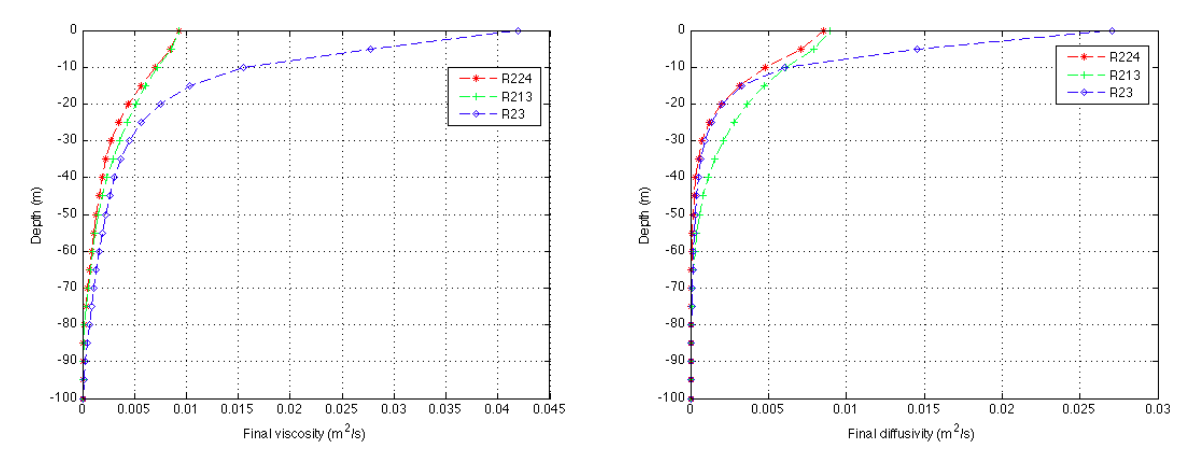
1z = h/N , with nodes z i = − h + i 1z, i = 0 ,...,N ,